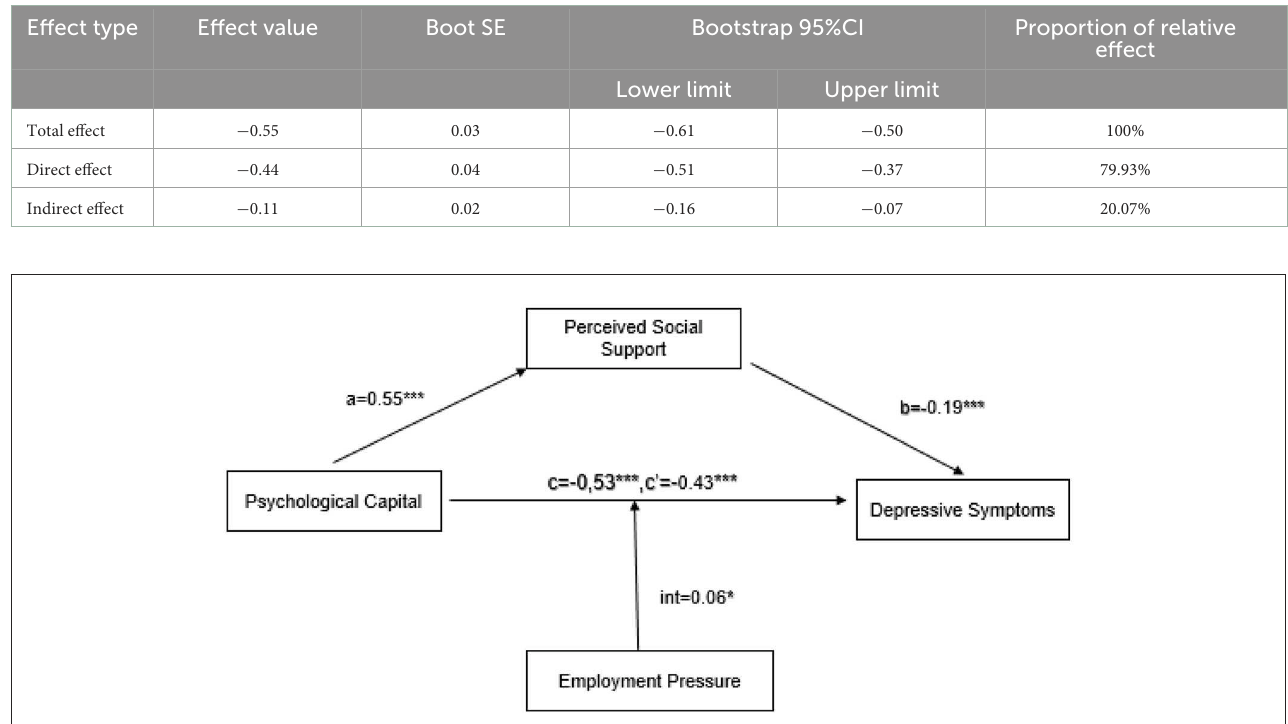
TABLE 3 Bootstrap results of the mediating effect of perceived social support.